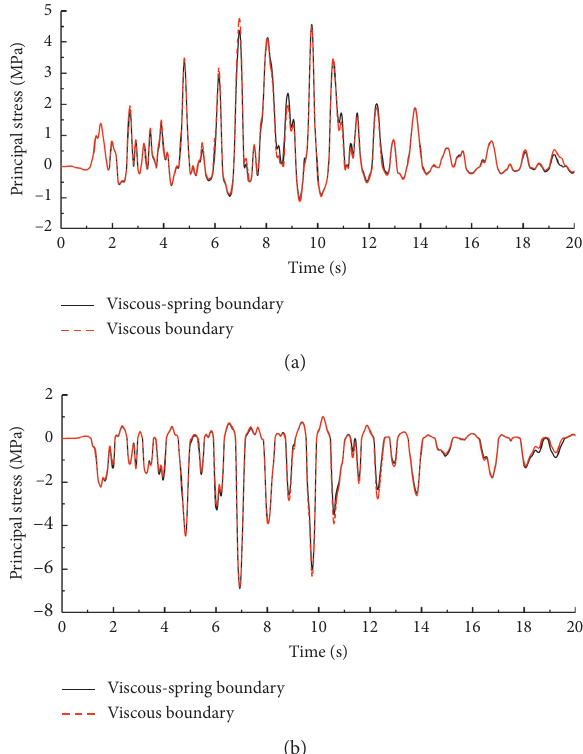
Figure 21: Time histories of principal stresses of the Jin’anqiao dam. (a) Principal tensile stress at dam heel. (b) Principal compressive stress at dam